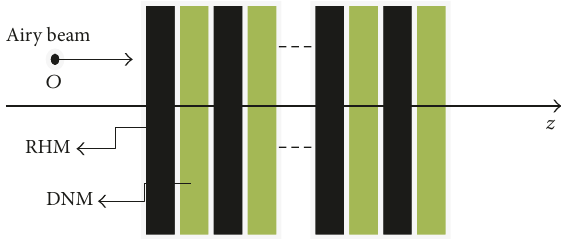
Figure 1: Light path schematic diagram of periodic slab system with